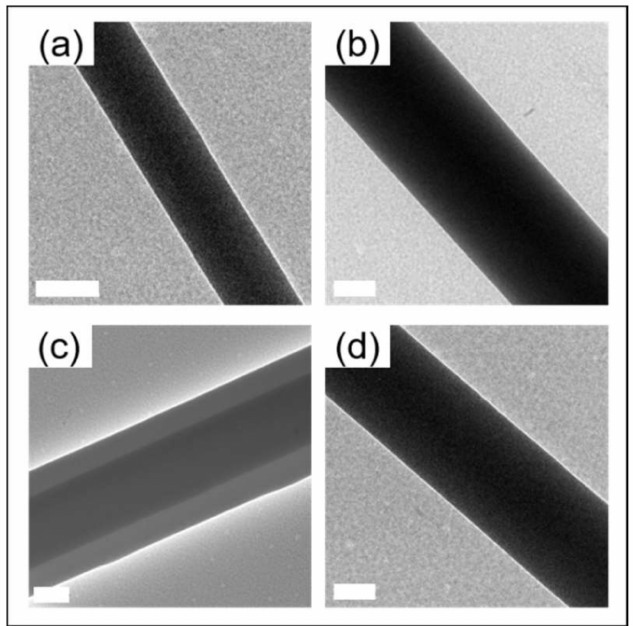
Figure 3. TEM images of nanofibers via co-axial centrifugal spinning. ( a ) Sample G: 7 w / v % PEO and 2:1 CCS/PEO; ( b ) Sample H: 6 w / v % PEO and 2:1 CCS/PEO; ( c ) Sample I: 7 w / v % PEO and 1:1 CCS/PEO; ( d ) Sample J: 6 w / v % PEO and 1:1 CCS/PEO. Scale bar: 200